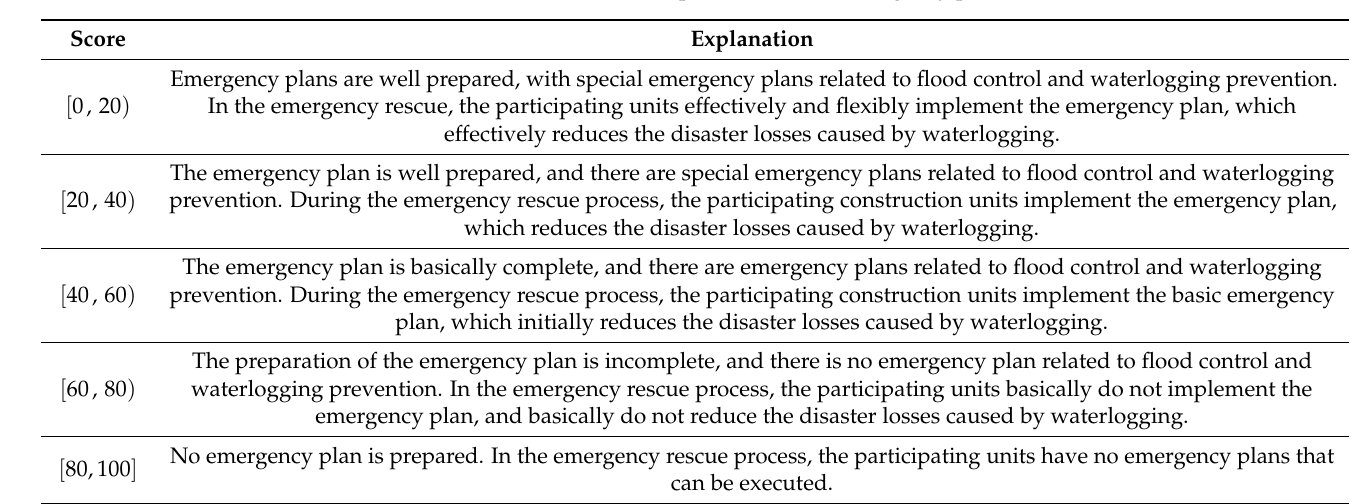
Table 4. Score basis for the implementation of emergency